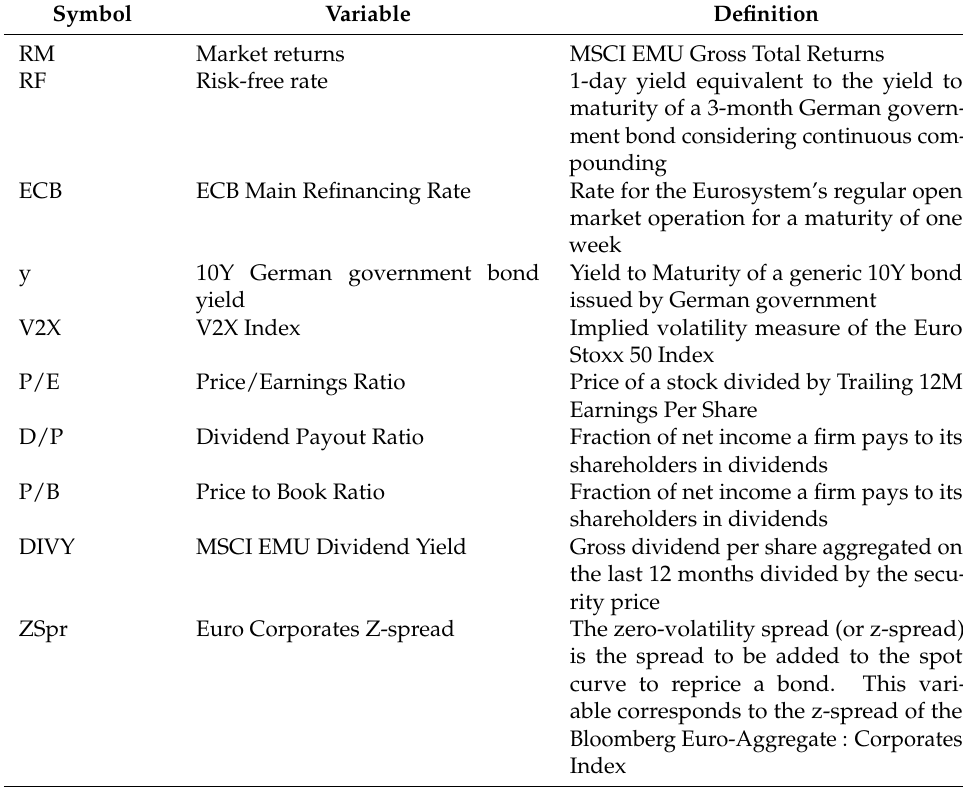
Table 2. Definition of the control variables used in linear regressions.